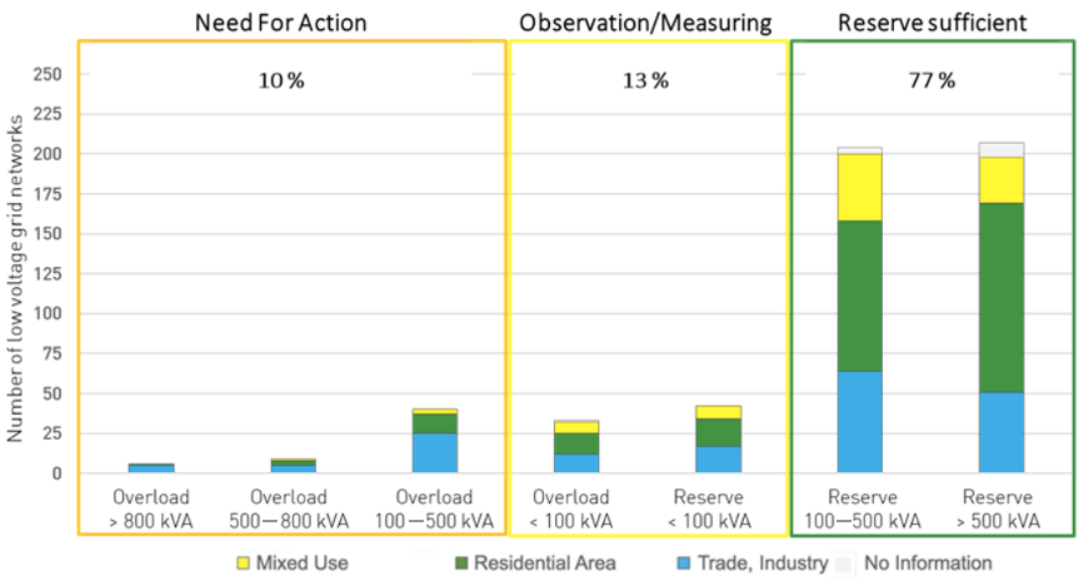
Figure 8. Analysis of the low-voltage grid including the additional demand from the 30% scenario.